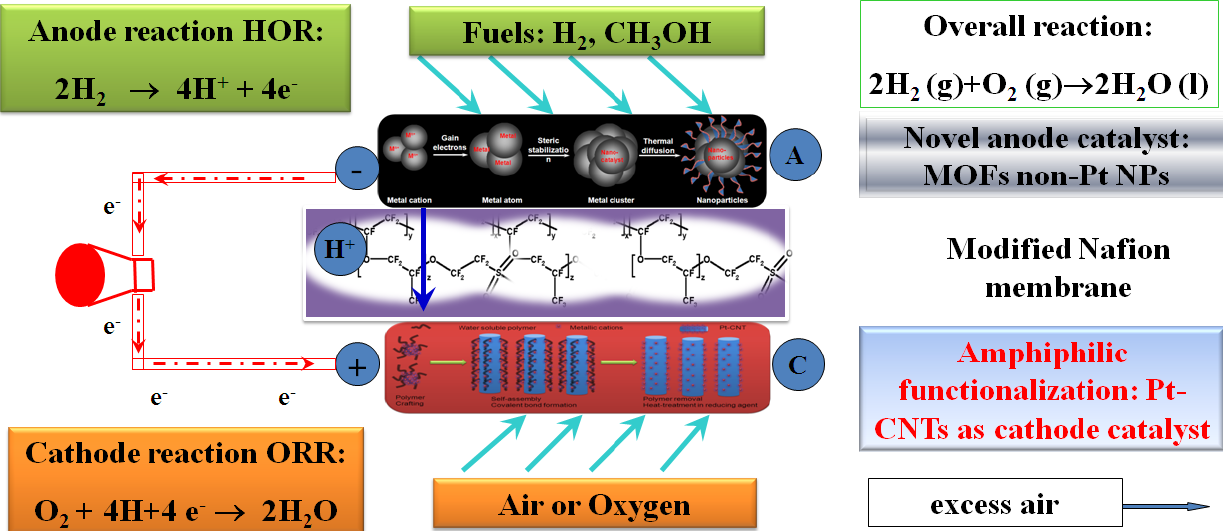
Figure 1. The operation schematic of proton exchange membrane fuel cells